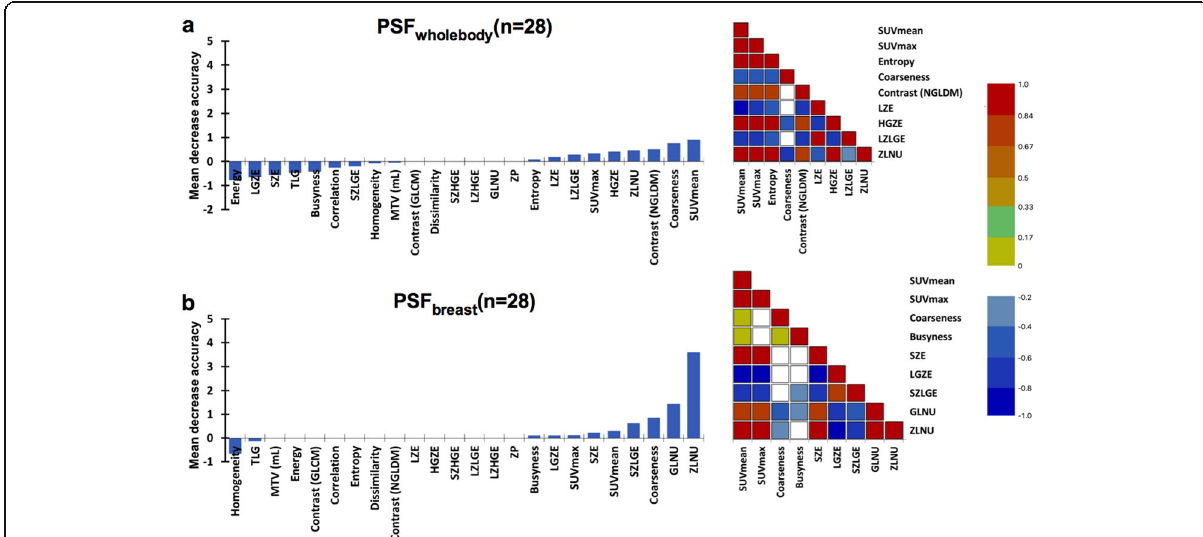
Fig. 2 Left panels display the mean decrease accuracy of textural features values and right panels display Spearman correlation matrixes of all PET metrics found to have positive mean decrease accuracy, whatever the value for PSF wholeBody ( a ) and PSF breast ( b ) reconstructions. For Spearman correlation matrixes, the blue colour corresponds to a correlation close to − 1 and the red colour corresponds to a correlation close to 1. The green corresponds to a correlation close to 0